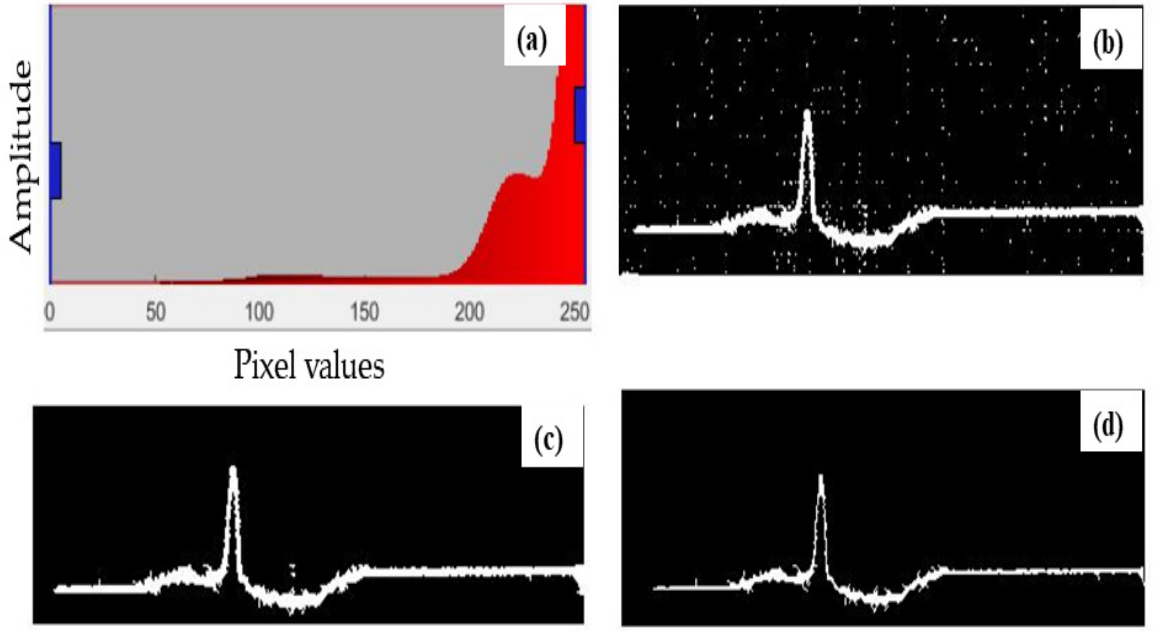
Figure 5. ( a ) Intensity of RGB distribution, ( b ) binary image of ECG, ( c ) clean binary image of ECG, ( d ) after a morphological operation.